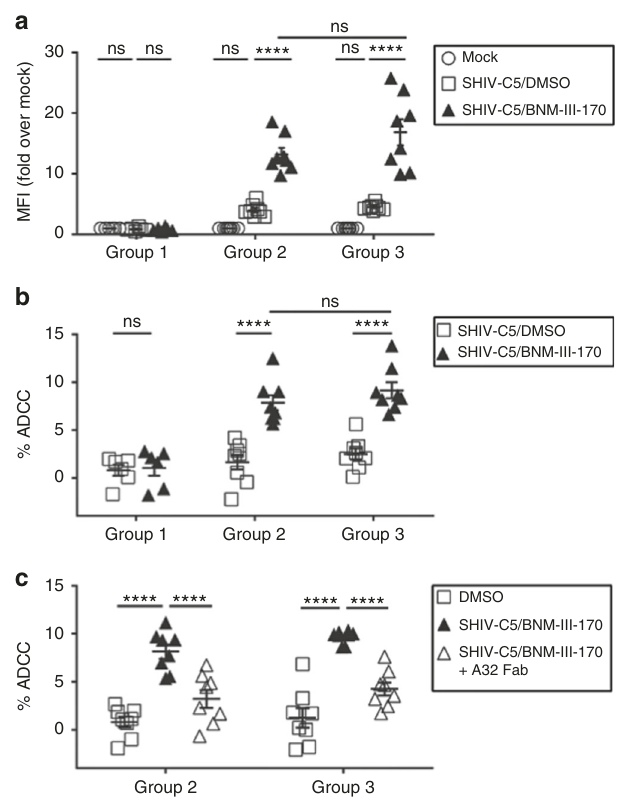
Fig. 3 CD4mc-dependent ADCC killing by immunized monkey sera. Primary CD4 + T lymphocytes from three healthy HIV-1-negative individuals were activated 37 , and then infected with SHIV-C5 virus for 48 h before performing the antibody binding and ADCC assays. a Surface staining of infected cells was done with 1:250 dilutions of sera collected from the monkeys on the day of SHIV-C5 Challenge 1. Serum was added in the presence of 50 μ M BNM-III-170 or an equivalent volume of DMSO (negative control) at 37 °C for 1 h. Goat anti-human antibody (AF-647) was used as the secondary antibody. The Mean Fluorescence Intensity (MFI) of AF-647 staining on Aqua Vivid (Invitrogen)-negative cells (living cells) is shown, relative to that of mock-infected cells. See Supplementary Fig. 9 for an example of the FACS gating strategy. b To evaluate ADCC, SHIV-C5- infected primary CD4 + T lymphocytes were incubated with autologous peripheral blood mononuclear cells (Effector:Target ratio of 10:1) from the same donor for 4 – 6 h at 37 °C in the presence of a 1:250 dilution of monkey serum and 50 μ M BNM-III-170 or equivalent volume of DMSO. The serum was collected from the monkeys on the day of SHIV-C5 Challenge 1. Infected cells were identi fi ed by staining with an Alexa Fluor (AF)-488- conjugated antibody against SIV p27 CA. The percentage of ADCC killing was determined with the following formula: [(% of p27 + cells in Targets plus Effectors) − (% of p27 + cells in Targets plus Effectors plus serum)]/ (% of p27 + cells in Targets) by gating infected (p27 + ) live (Aqua Vivid- negative) target cells, as described 37 . c To evaluate the effect of the A32 Fab on the susceptibility of SHIV-C5-infected cells to ADCC mediated by the serum samples, 5 μ g/ml of A32 Fab was added to the ADCC assay described in b . The results shown represent the average of three experiments. Statistical signi fi cance was tested by One-way ANOVA.